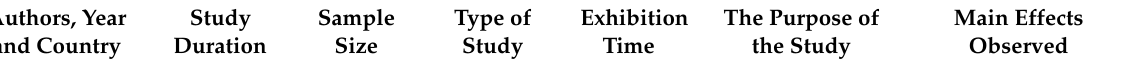
Table 1. Summary of identified randomized clinical trials on intermittent fasting